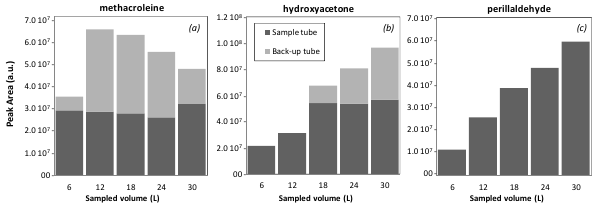
1 2 Fig. 8. Evaluation of breakthrough volumes for carbonyl compounds on PFBHA-coated Tenax TA sorbent tubes (a) methacroleine, (b) hydroxyacetone (c) perillaldehyde. 3 “Peak Area” refers to the m/z 181 extracted ion chromatogram obtained in the electron ionisation mode, in area units.